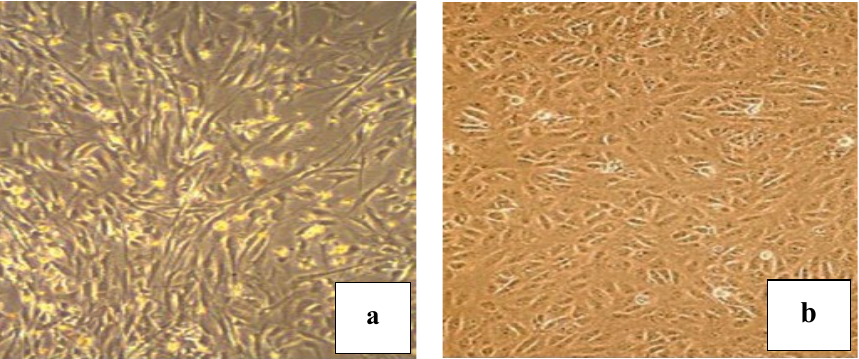
Figure 8. ( a ) cultured gingival mesenchymal stem cells (GMSCs), ( b ) cultured squamous cell carcinoma (SCC) cells, scale bars = 400 µm.